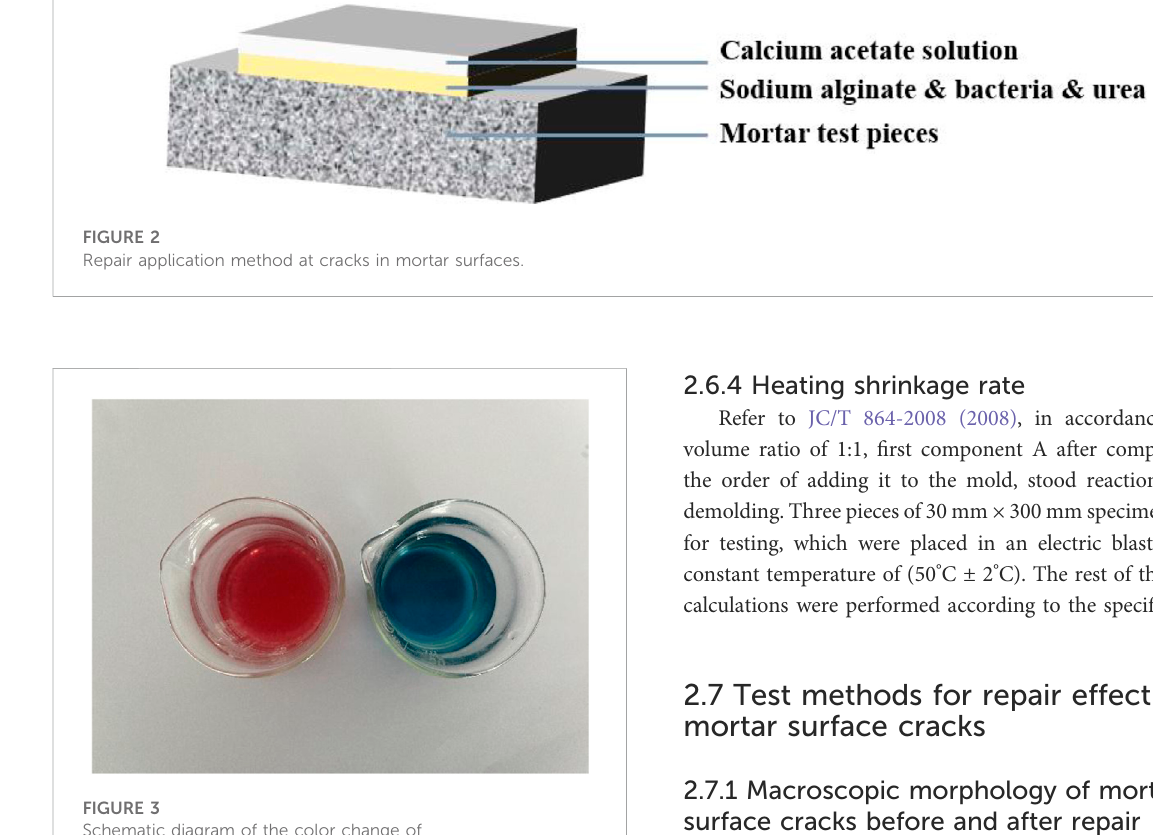
FIGURE 3 Schematic diagram of the color change of ethylenediaminetetraacetic acid titration test